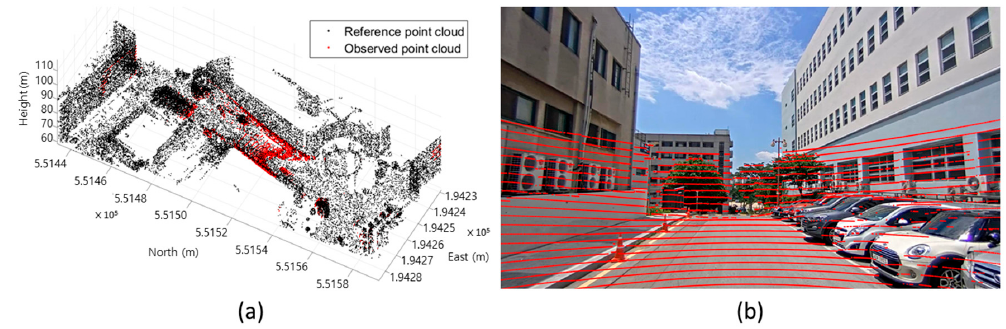
Figure 16 . Operation of developed MMS under driving conditions: ( a ) georeferenced point cloud (red: observed by MMS, black: point cloud observed and georeferenced by terrestrial laser scanning data and GNSS); and ( b ) point cloud projected onto image.